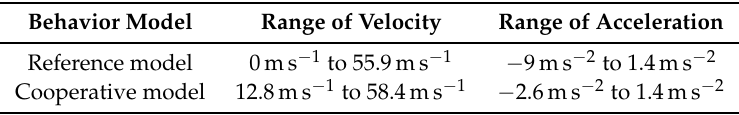
Table 3. Range of velocity and